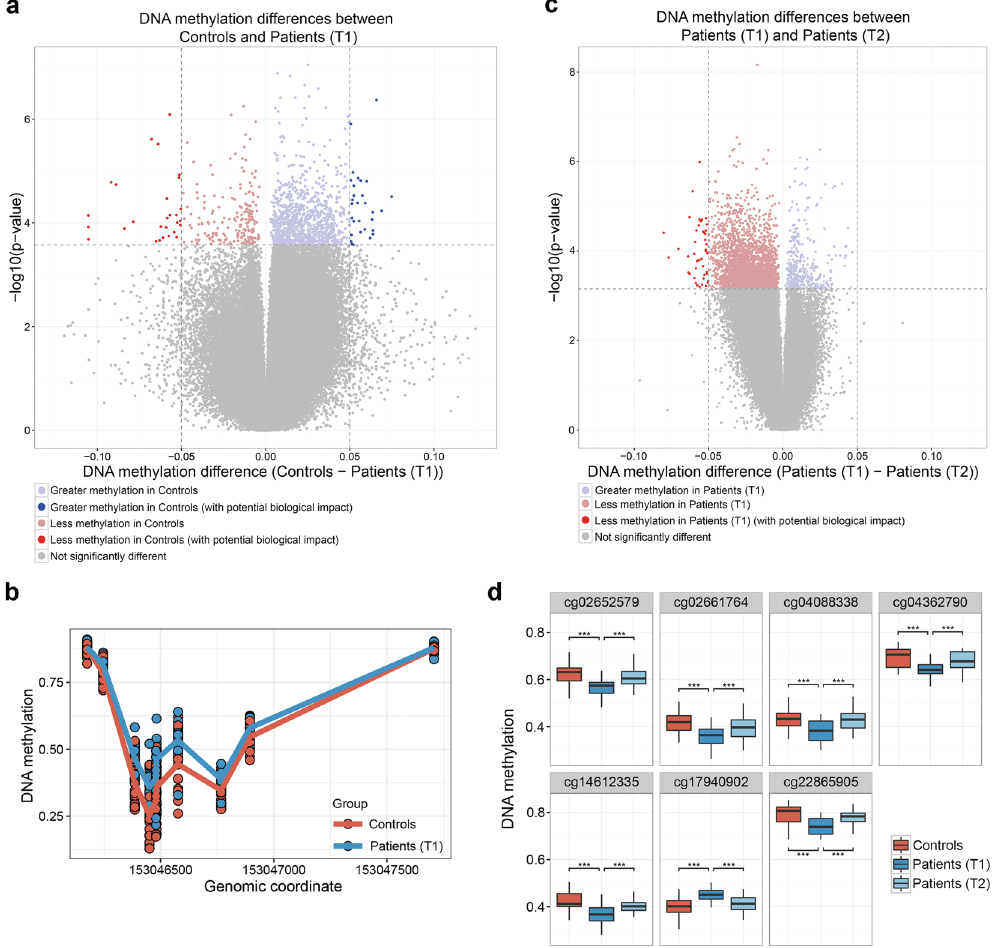
Figure 1. Differential sites and regions identified in the 450 K array analyses. ( a ) Volcano plot depicting differences in DNAm levels between controls and patient (T1) for each probe in the corrected 450 K dataset (indicated on X axis) against FDR (indicated on Y axis, on –log10 scale). Dashed horizontal line denotes FDR threshold of 0.1 while dashed vertical lines denote DNAm difference thresholds of − 0.05 and 0.05, respectively. ( b ) Differential DNAm detected by DMRcate in the promoter region of the SRPK3 gene (chrX:153, 046, 386–153, 046, 482). ( c ) Volcano plot depicting differences in DNAm levels between patients (T1) and patients (T2) as described in panel (a). ( d ) DNAm levels of seven sites which show reversion of DNAm post-treatment. *** Indicate an FDR <